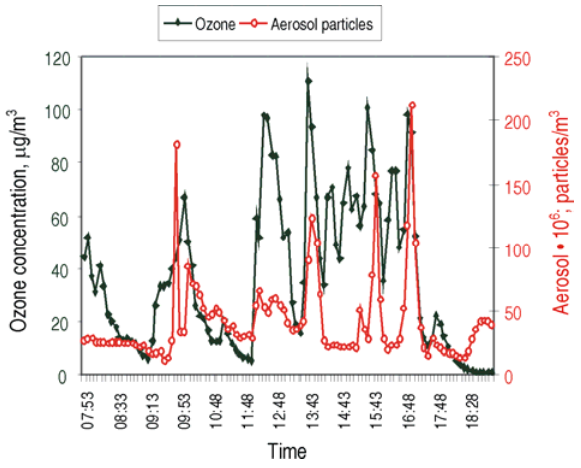
Fig. 6. Variation of ozone and aerosol numeracal concent- rations (with additional room ventilation)